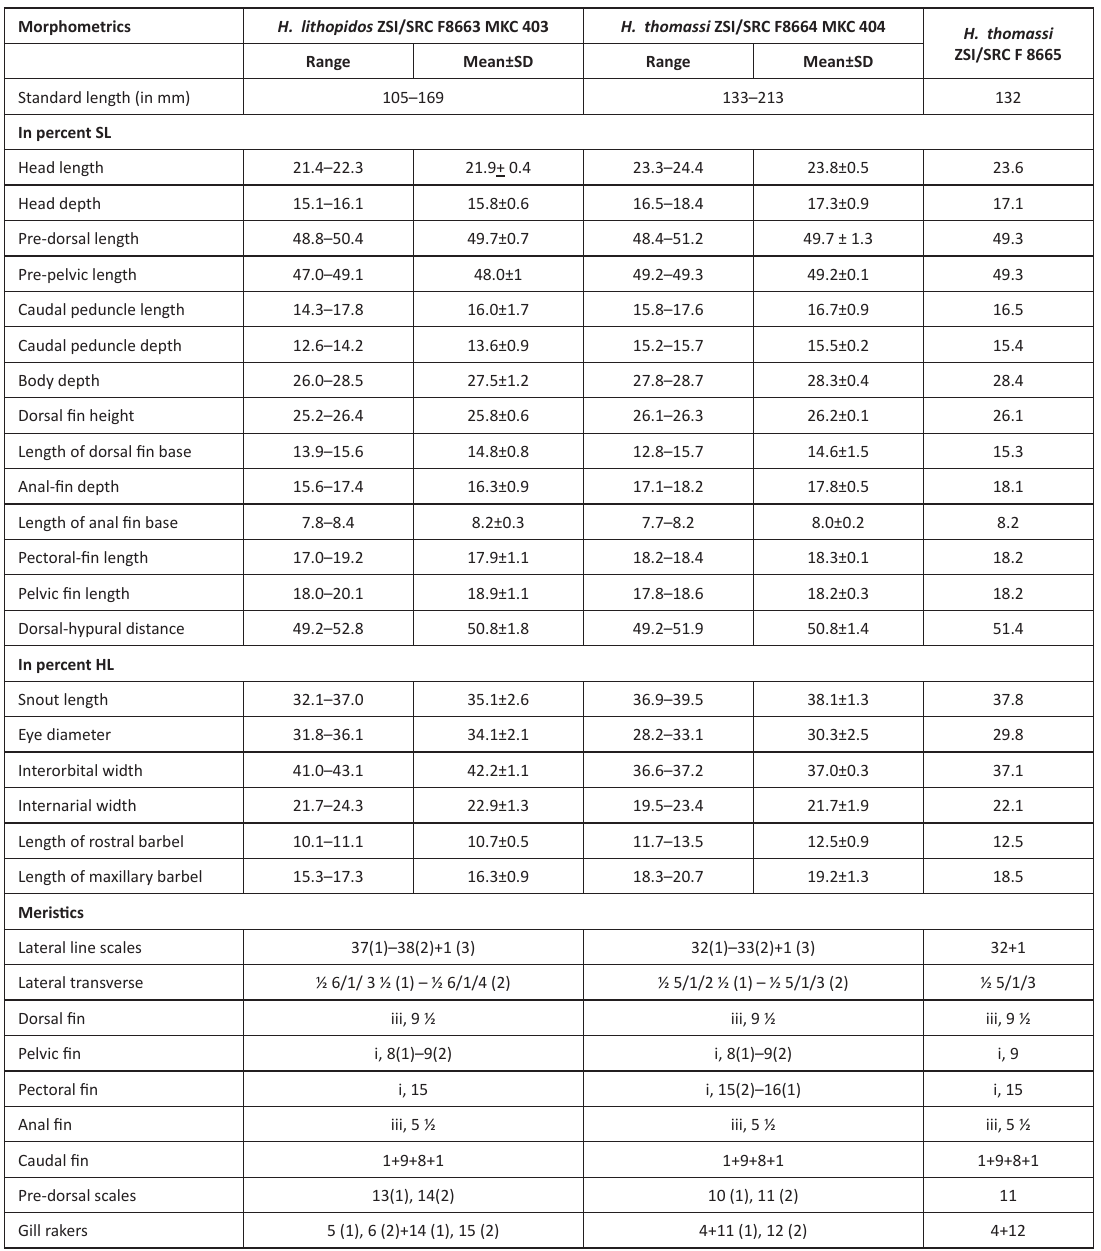
Table 1. Biometric and meristic data of Hypselobarbus lithopidos (ZSI/SRC F 8663, 2 exs. and MKC 403, 1 ex.) from Phalguni River, Mangalore, Karnataka and Hypselobarbus thomassi from Kempu Hole River, Karnataka (ZSI/SRC F 8664, 2 exs. and MKC 404, 1 ex.) and Athirapally